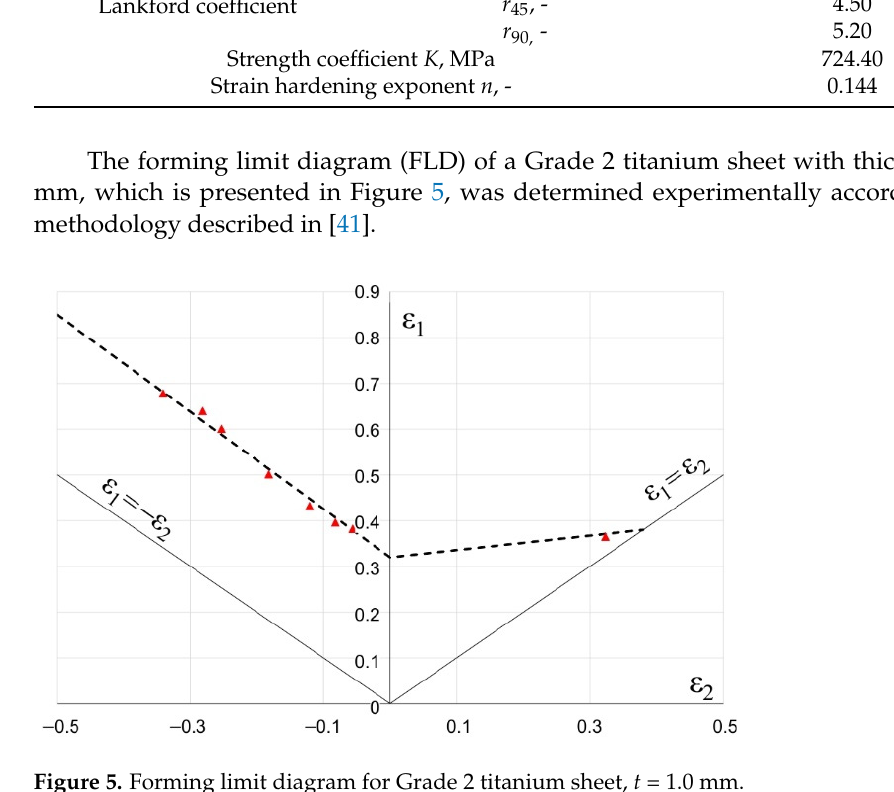
Figure 6. Subsequent stages of forming handle part from Grade 2 titanium sheet: ( a ) initial forming with magnification of wrinkling area; ( b ) supplementary forming; ( c ) trimming; ( d ) final forming. The experimental tests showed that it is possible to produce the handle parts of Grade 2 titanium sheet with standard steel tools. However, the lack of a blank holder in the initial forming process results in the wrinkling of the sheet, both in the flange of the drawn part and on its surface (Figure 7a). On the other hand, forming with the blank holder in dry conditions very often leads to fracture (Figure 7b). Moreover, the experiments showed a high tendency to create titanium protrusions on the working surfaces of the steel die, which in turn leads to galling (Figure 7b) and deterioration of the quality of the drawn part surface. Titanium protrusions cause scratches and dents that cannot be removed in subsequent forming operations. Therefore, lubrication was necessary to separate the rub- bing surfaces (i.e., the deformed material—titanium—and the die). Lubricant based on rapeseed oil with an additive of boric acid [42] was used. The use of the blank holder and technological lubricant, made it possible to obtain a good-quality titanium drawn part (Figure 7c). To eliminate this defect, it was decided to modify the forming process using numer- ical simulations. Figure 7. Results of forming: ( a ) with no blank holder—visible wrinkling, ( b ) with blank holder in dry conditions—visible crack and marks of galling, ( c ) with blank holder and lubrication—there are no defects.